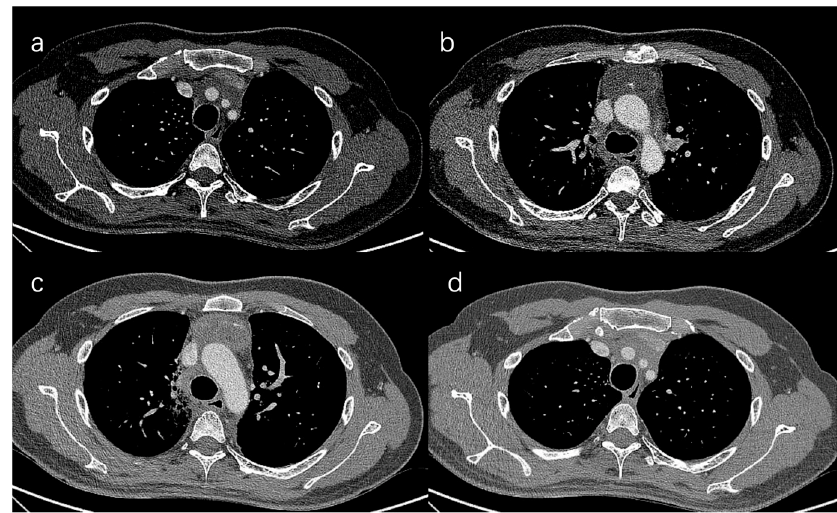
Figure 3. CT scan of 32-year-old patient with thymoma. ( a ) The relationship of tumor to the top of SVC, which is tumor free. The left innominate vein joins the SVC; ( b ) The relationship of tumor and the top of superior vena cava which is tumor free; ( c ) The relationship of tumor and the aorta arch which is potentially tumor free; ( d ) The relationship of tumor and the aorta branches, which are potentially tumor free.